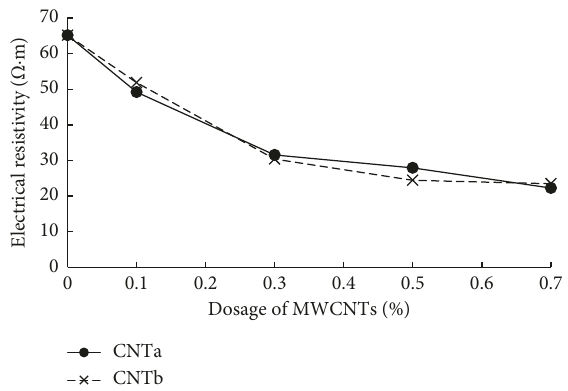
Figure 7: Electrical resistivity of ECCs containing different types of